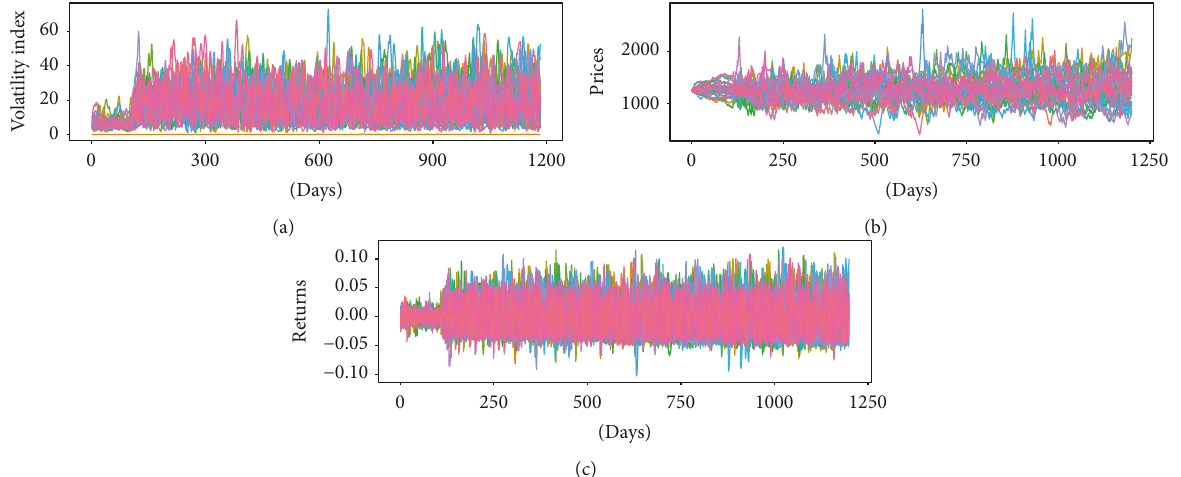
Figure 8: Time series of volatility index (a), prices (b), and returns (c), when 𝑔 = 1 = 0 and 𝑔 = 2 = 𝑔 = 3 = 0